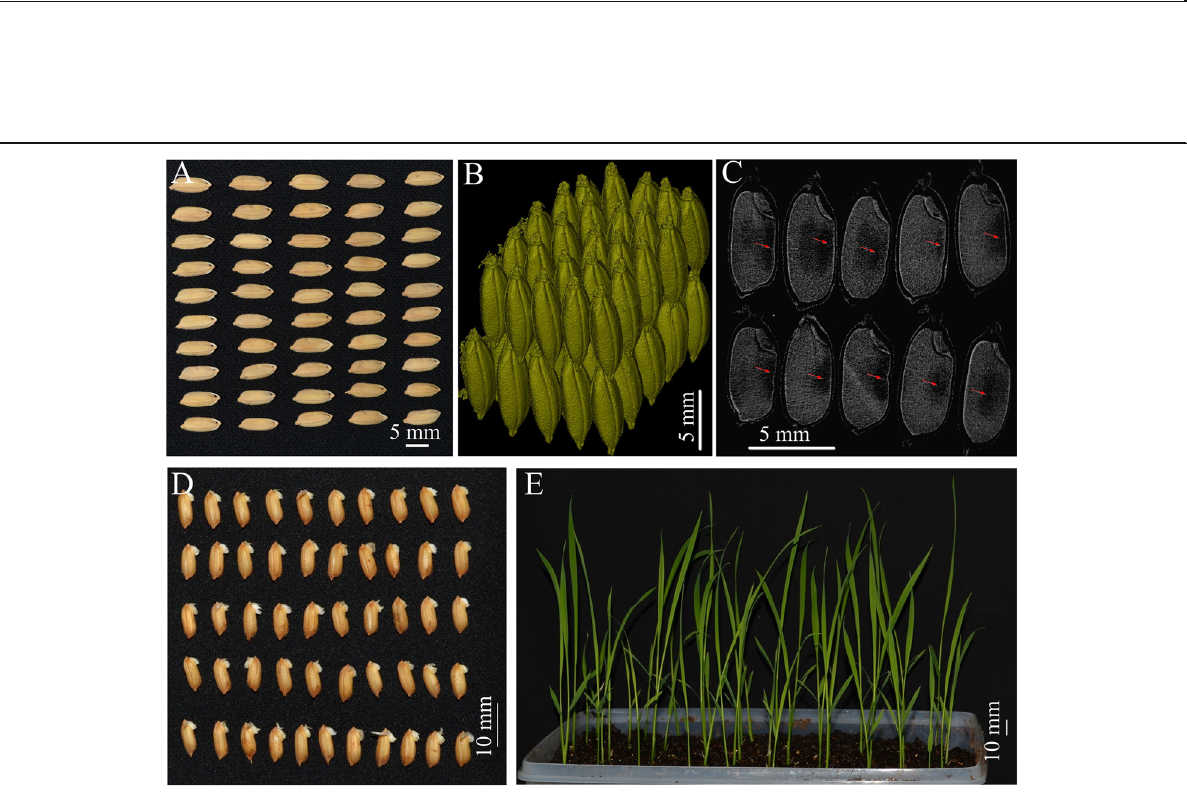
Fig. 5 in vivo analysis of rice (Zhenshan 97B) chalkiness. a 50 living mature rice seeds; b Separated and reconstructed 3D image of rice grain; c One of cross-sections of rice grain; d Germination analysis of rice grain after X-ray scanning. e Growth analysis of rice seedlings after X-ray scanning. Dark areas indicated by red arrows represent the location of rice chalkiness. Three independent biological replicates were